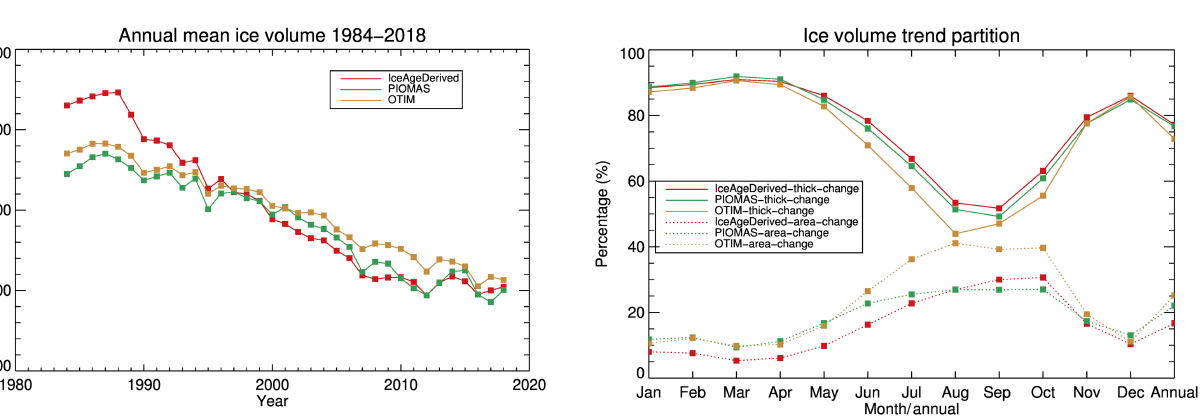
Figure 18. Time series of annual mean Arctic ice volume from 1984 to 2018 derived from ice age, PIOMAS, and OTIM over the Arctic Ocean.